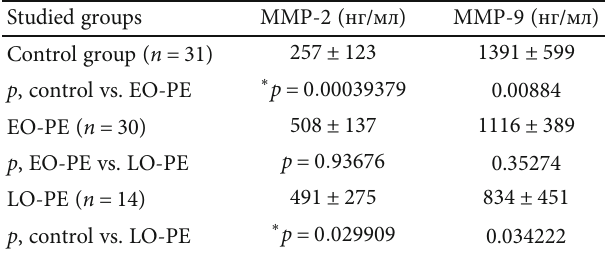
Table 2: MMP-2 and MMP-9 levels in the control group, EO-PE, and